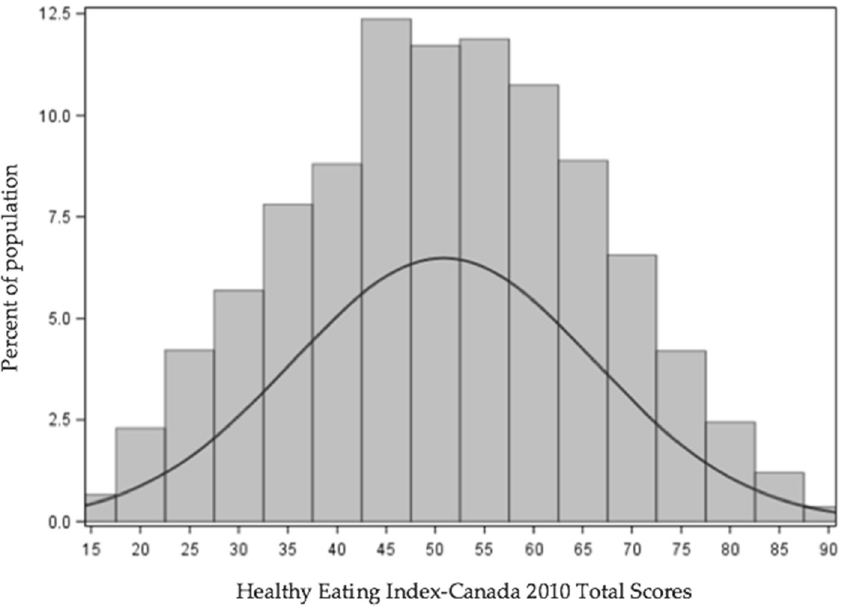
Figure 1. Weighted distribution of Healthy Eating Index-Canada 2010 scores among Canadian adults ( n = 12,805). Results are for single day of recall. Data were trimmed according to Statistics Canada’s data release requirements.